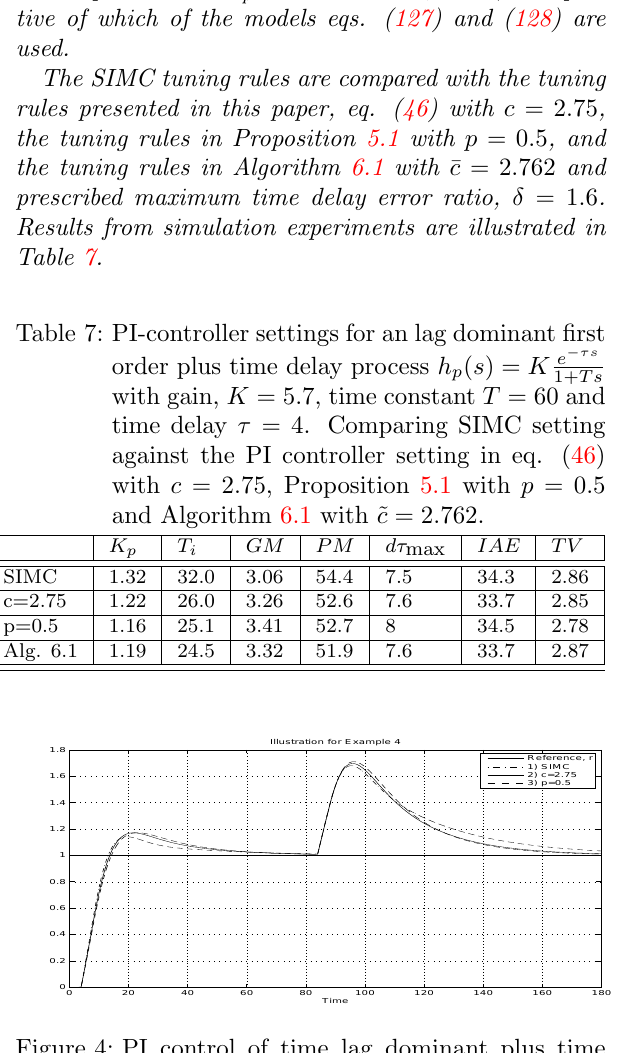
Figure 4: PI control of time lag dominant plus time delay process, h p ( s ) = K e − τs . PI-controller 1+ Ts h c ( s ) = K p 1+ T i s with settings as in Table T i s